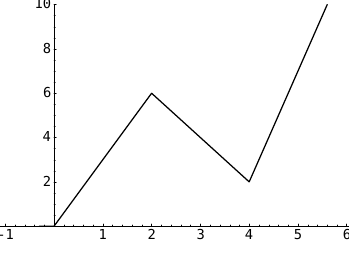
Figure 6. The graphics of function f